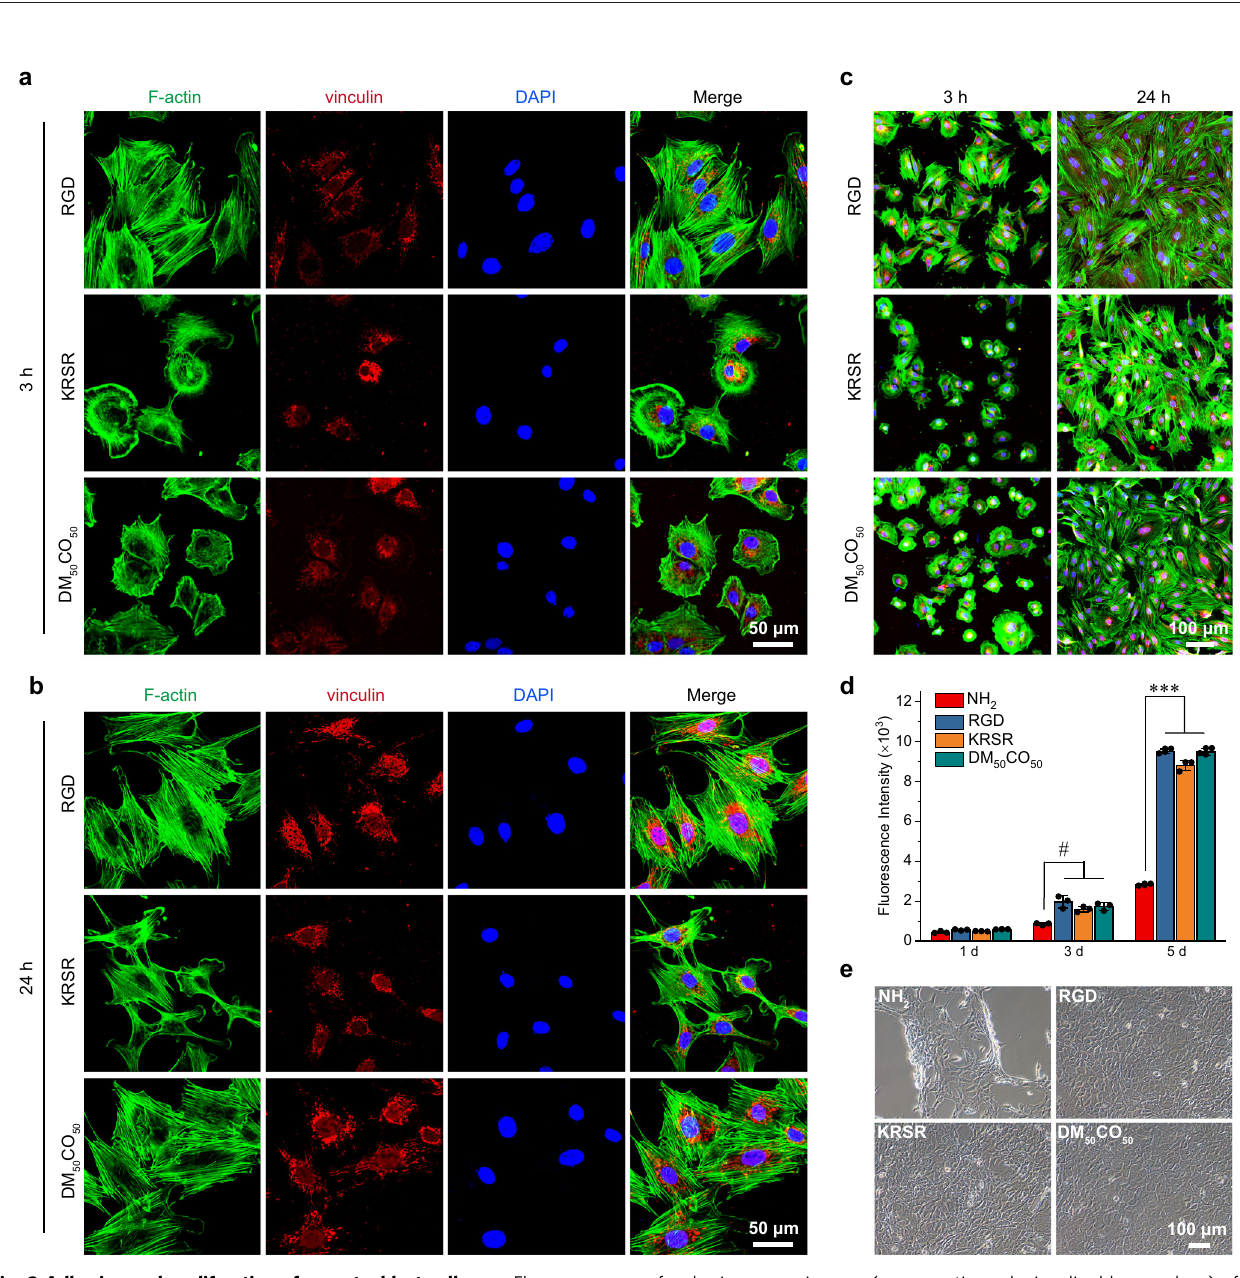
Fig. 2 Adhesion and proliferation of preosteoblast cells. a – c Fluorescence confocal microscope images (green, actin; red, vinculin; blue, nucleus) of preosteoblast cells on RGD, KRSR, and DM 50 CO 50 -modi fi ed surfaces after cell seeding for 3 h ( a ) and 24 h ( b ), Scale bar: 50 μ m. Lower magni fi cation images ( c ) after cell seeding for 3 and 24 h, Scale bar: 100 μ m. d Cell proliferation after 1, 3, and 5 days of culture. Quanti fi cation of cell density was done with Alamar Blue assay. e Bright fi eld images of preosteoblast cells cultured on NH 2 , RGD, KRSR, and DM 50 CO 50 -modi fi ed surfaces for 5 days. Scale bar: 100 μ m. Data (in d ) represent mean ± s.d. ( n = 3). Statistical analysis: one-way ANOVA with Tukey post-test, # p < 0.05, *** p <